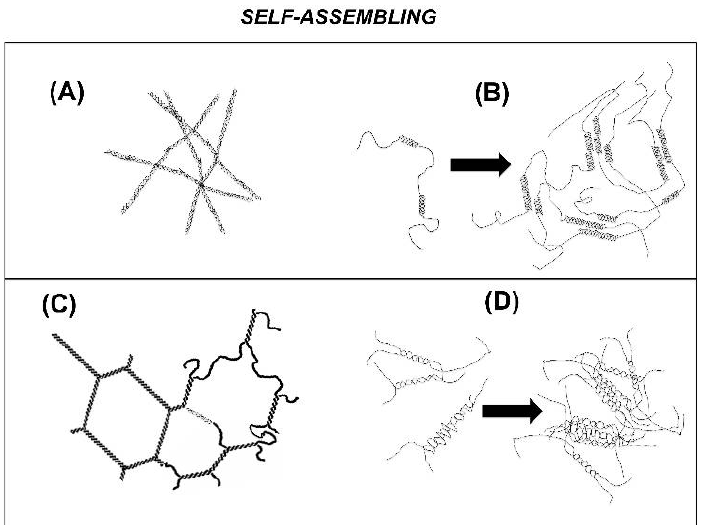
Figure 2. The most popular models of the self-assembling of carrageenan single helices ( A , B ) or double helices ( C , D ) giving rise to a three dimensional network showing elasticity: ( A , C ) represent self-assembling at the helical (or secondary structure) level, whereas ( B , D ) represent self-assembling at the super-helical level (tertiary or quaternary structures).